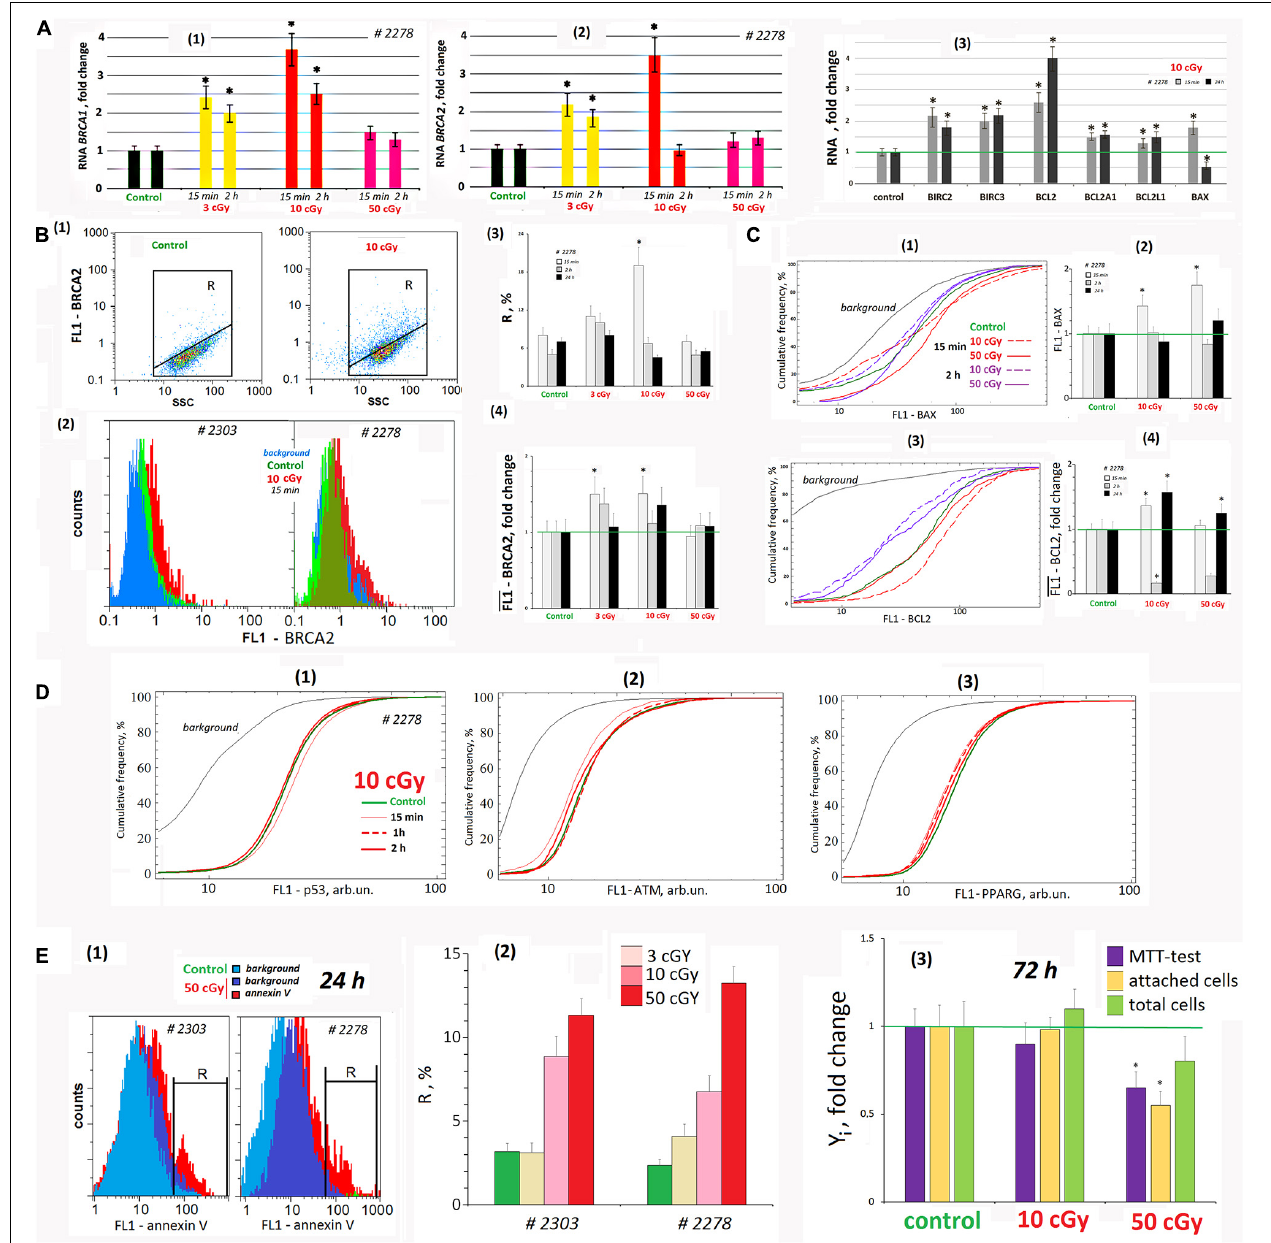
FIGURE 7 | LDIR affect the processes of apoptosis and repair in the cells. (A) Quantitative reverse transcriptase–polymerase chain reaction. (1) and (2) Changes in the levels of RNA BRCA1 and RNA BRCA2 in LDIR-treated cells compared to control (three biological replicates). The time of cell cultivation after LDIR is shown in the figure. (3) Proapoptotic gene BAX 1 RNA level and BIRC and BCL families antiapoptotic genes changes in the MSCs (10 cGy) compared to control (three biological replicates). Reference gene TBP . * p < 0.001 ( U test). (B) FACS. BRCA2 protein level changes. (1) Plots: FL1- BRCA2 versus SSC. R: gated area, cells with an increased BRCA2 level. (2) MSCs (10 cGy, 15 min after LDIR) with varying FL1–BRCA2 signal distribution. (3) The content of the cells with an increased BRCA2 level. (4) Median FL1–BRCA2 signals. Average values and SD are given for three experiments. * p < 0.001 ( U test). The time of cell cultivation after LDIR is shown in the figure. (C) FACS. (1) The cumulative distribution of the MSCs (10 and 50 cGy) with varying FL1–BAX1 signal. (2) Median signals for FL1–BAX1. (3) The cumulative distribution of the MSCs (10 and 50 cGy) with varying FL1–BCL2 signal. (4). Median signals for FL1–BCL2. The cultivation times and radiation doses are shown in the figure. Average values and SD are given for three experiments. * p < 0.001 ( U test). (D) FACS. (1–3) The cumulative distribution of the MSCs (10 cGy) with varying FL1–p53, FL1-ATM, and FL1–PPARG signals. The time of cell cultivation after LDIR is shown in the figure. (E) FACS (1, 2). (1) The distribution of the MSCs (50 cGy) with varying FL1–annexin V. R: gated area, cells with an increased annexin V level. (2) The content of the cells with an increased annexin V level. (3) Evaluation of cell viability 72 h after irradiation. MTT test, the number of the attached cells, and the total cell number. Parameter values are normalized to the control values.